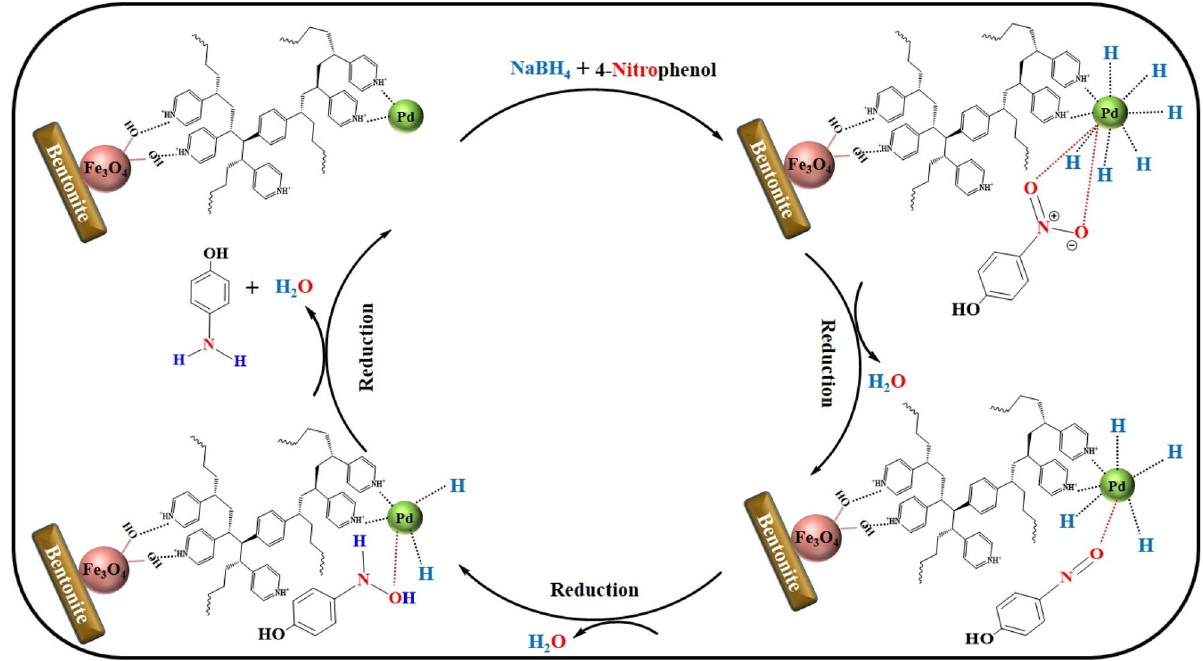
Figure 3. A possible mechanism for the catalytic reduction of nitroarene compounds by recyclable Fe-Ben / PVP-DVB/Pd